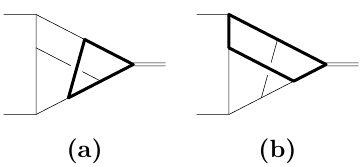
Figure 6. Mixed sectors. The notation is the same as for figure